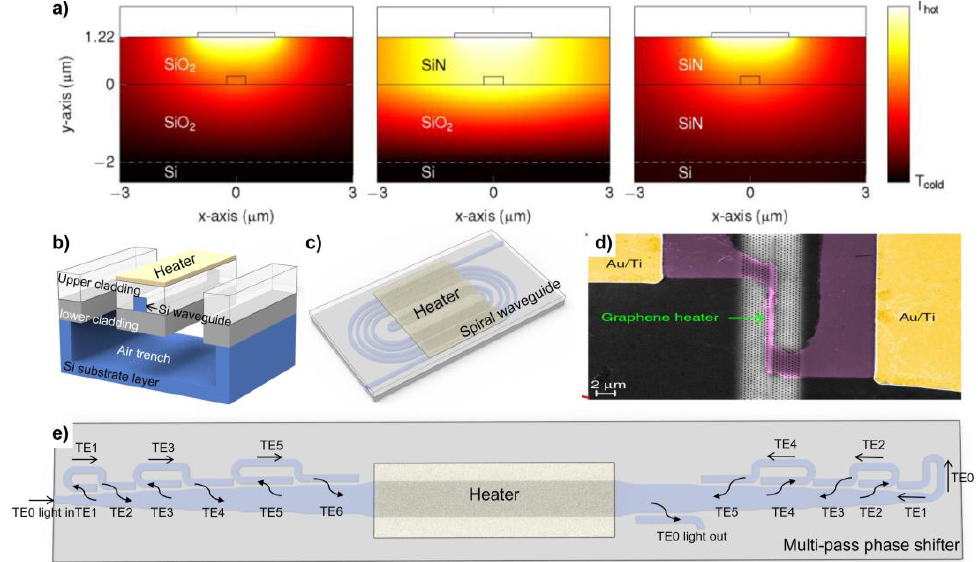
Figure 7. ( a ) Steady-state heat distribution for conventional thermo-optics phase shifters with different claddings (reprinted with permission from [68] © The Optical Society.), ( b ) free-standing thermo-optics phase shifter, ( c ) spiral waveguide thermo-optics phase shifter, ( d ) slow-light-enhanced thermo-optics phase shifter with graphene heater (reprinted with permission from [69] © 2017 Spring Nature), ( e ) multi-pass structure-based thermo-optics phase